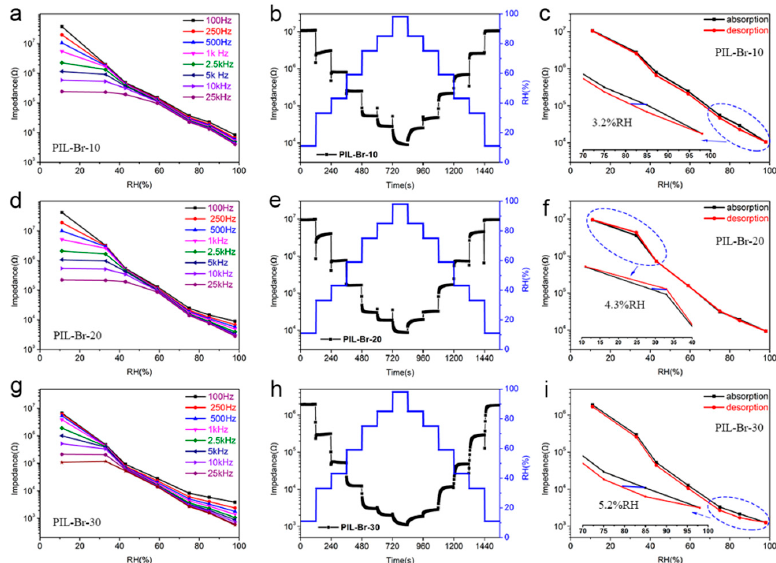
Figure 4. Thickness-dependent performance of PIL-Br humidity sensors: the impedance at varying RH levels measured under various frequencies: ( a ) PIL-Br-10, ( d ) PIL-Br-20, ( g ) PIL-Br-30, respectively; the dynamic response of PIL-Br sensors for increasing RH from 11% to 98% RH followed by a return to the initial state: ( b ) PIL-Br-10, ( e ) PIL-Br-20, ( h ) PIL-Br-30, respectively; the humidity hysteresis of ( c ) PIL-Br-10, ( f ) PIL-Br-20 and ( i ) PIL-Br-30, respectively.